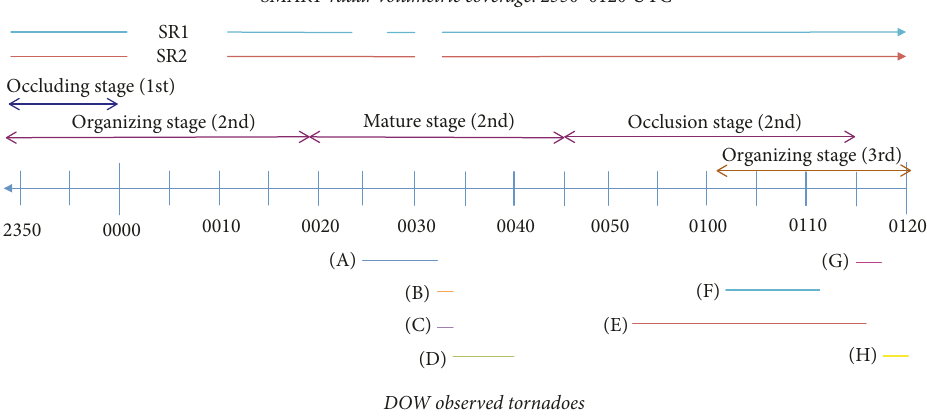
Figure 1: Timeline for SMART-radar observations, mesocyclone lifecycles, and tornado lifecycles (marked from (A) to (H) as indicated by a DOW radar that was close to the hook